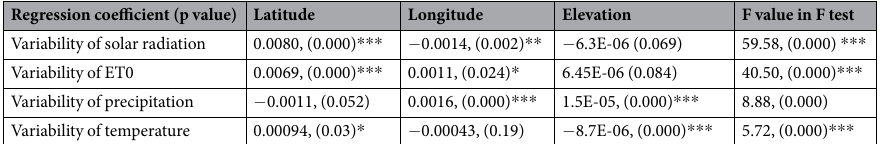
Regression coefficient (p value) Latitude